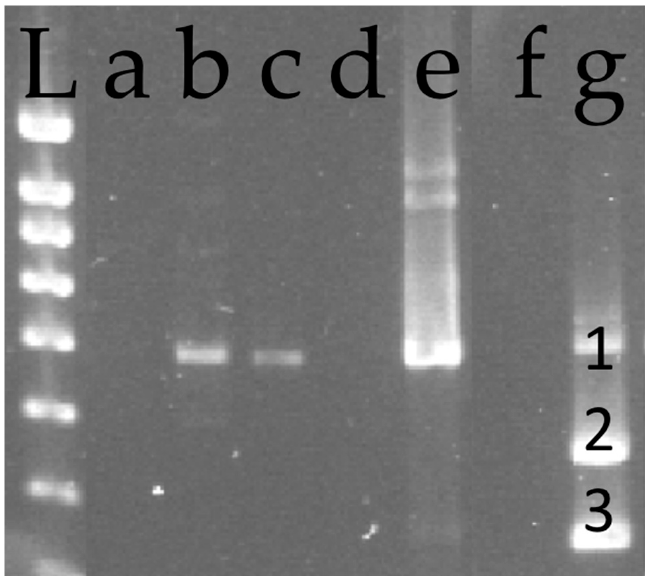
Figure 2. Agarose gel electrophoretic analysis of DNA fragments amplified from Pulvinaria vitis crawlers fed with purified GVA virions by reverse transcription-polymerase chain reaction